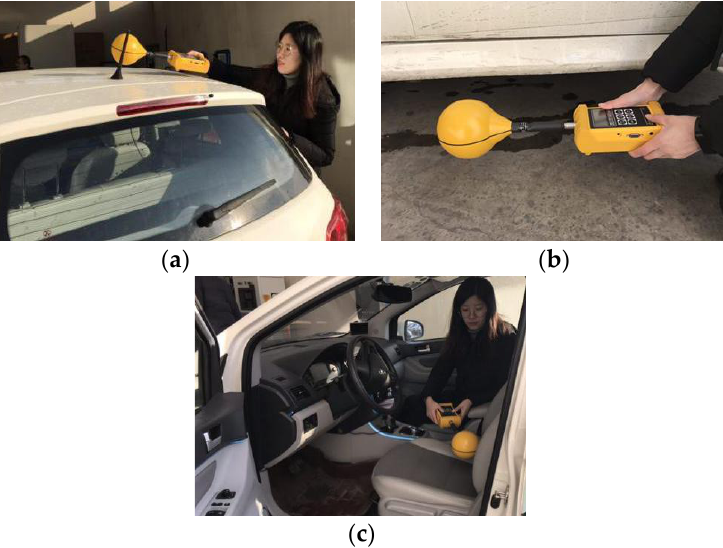
Figure 23. Testing at different points: ( a ) the antenna; ( b ) 7.5 cm point from the ground; ( c ) the seat.